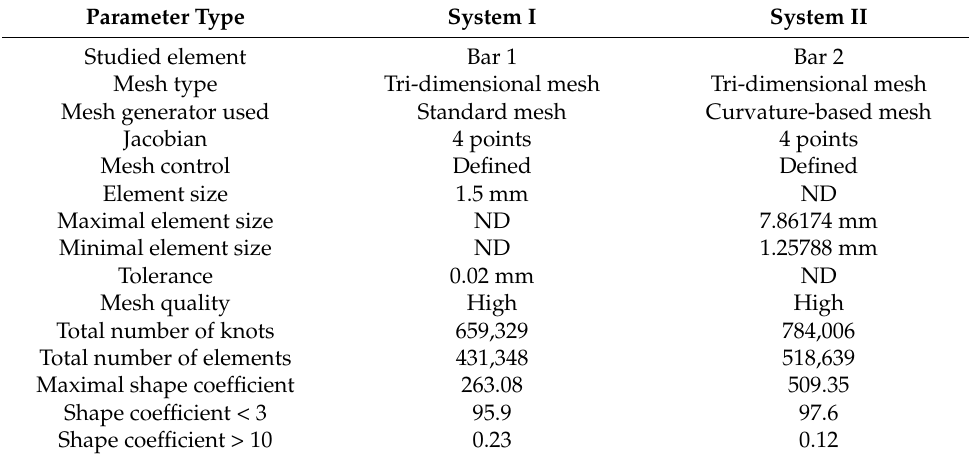
Table 3. FEA mesh parameters for systems I and